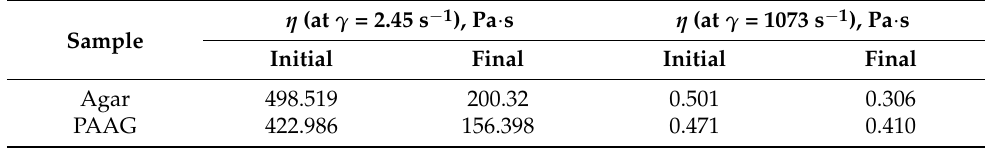
Table 3. Effective viscosity at minimum ( γ = 2.45 s −1 ) and maximum ( γ = 1073 s −1 ) shear rates.